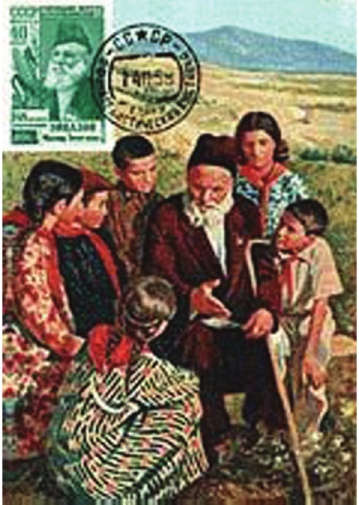
Figure 3: 1956 USSR stamp depicting 148 years old Mahmud Eyvazov, the oldest person in the Soviet Union and living in Azerbaijan. The fact that a stamp was produced commemorating this man indicates the role of national pride in claims such as these (Permission, Azerbaijan